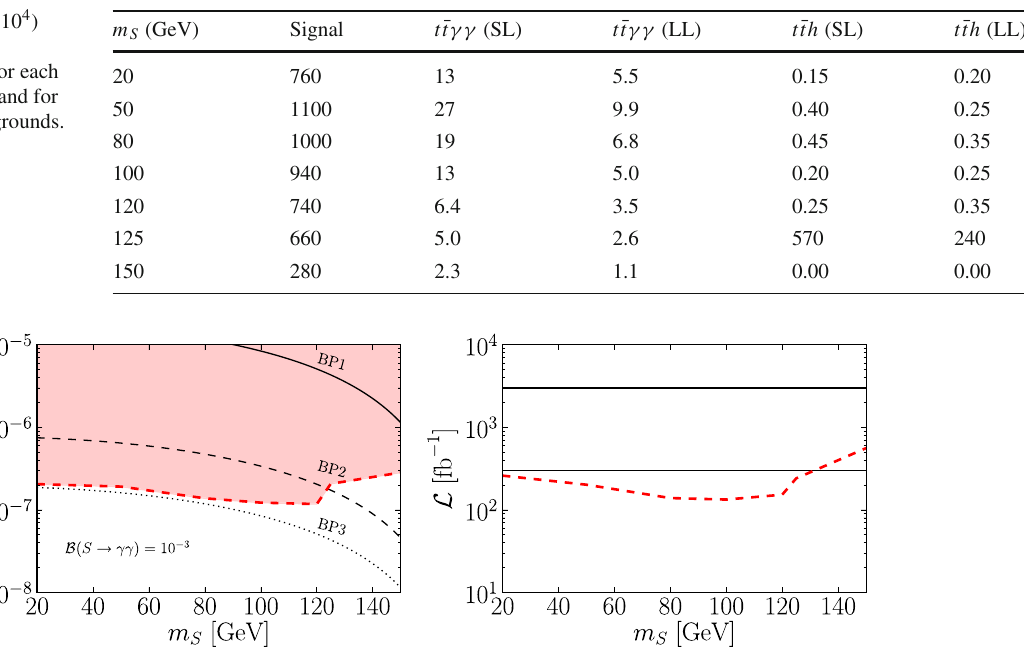
Fig. 4 (Left) Branching ratios that can be tested in the γγ channel. Superimposed are the theoretical expectations in the three BPs. (Right) Luminosity required to test B ( t → St , S → γγ) = 10 − 6 . Superimposed are L = 300 fb − 1 and 3000 fb −